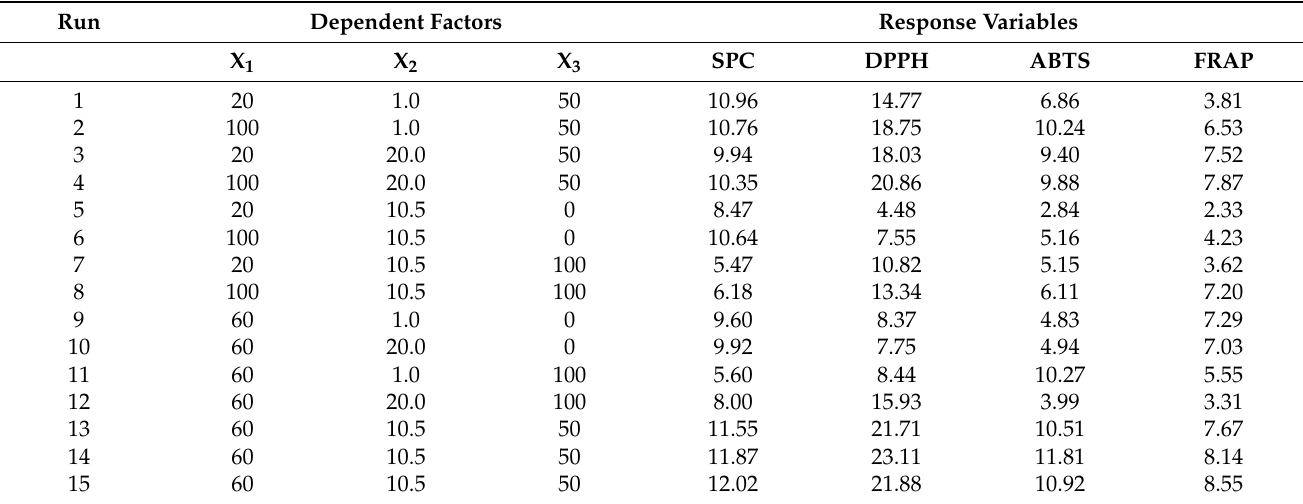
Table 2. Experimental Box-Behnken design (BBD), with natural and coded values for the factors, and response variable values.